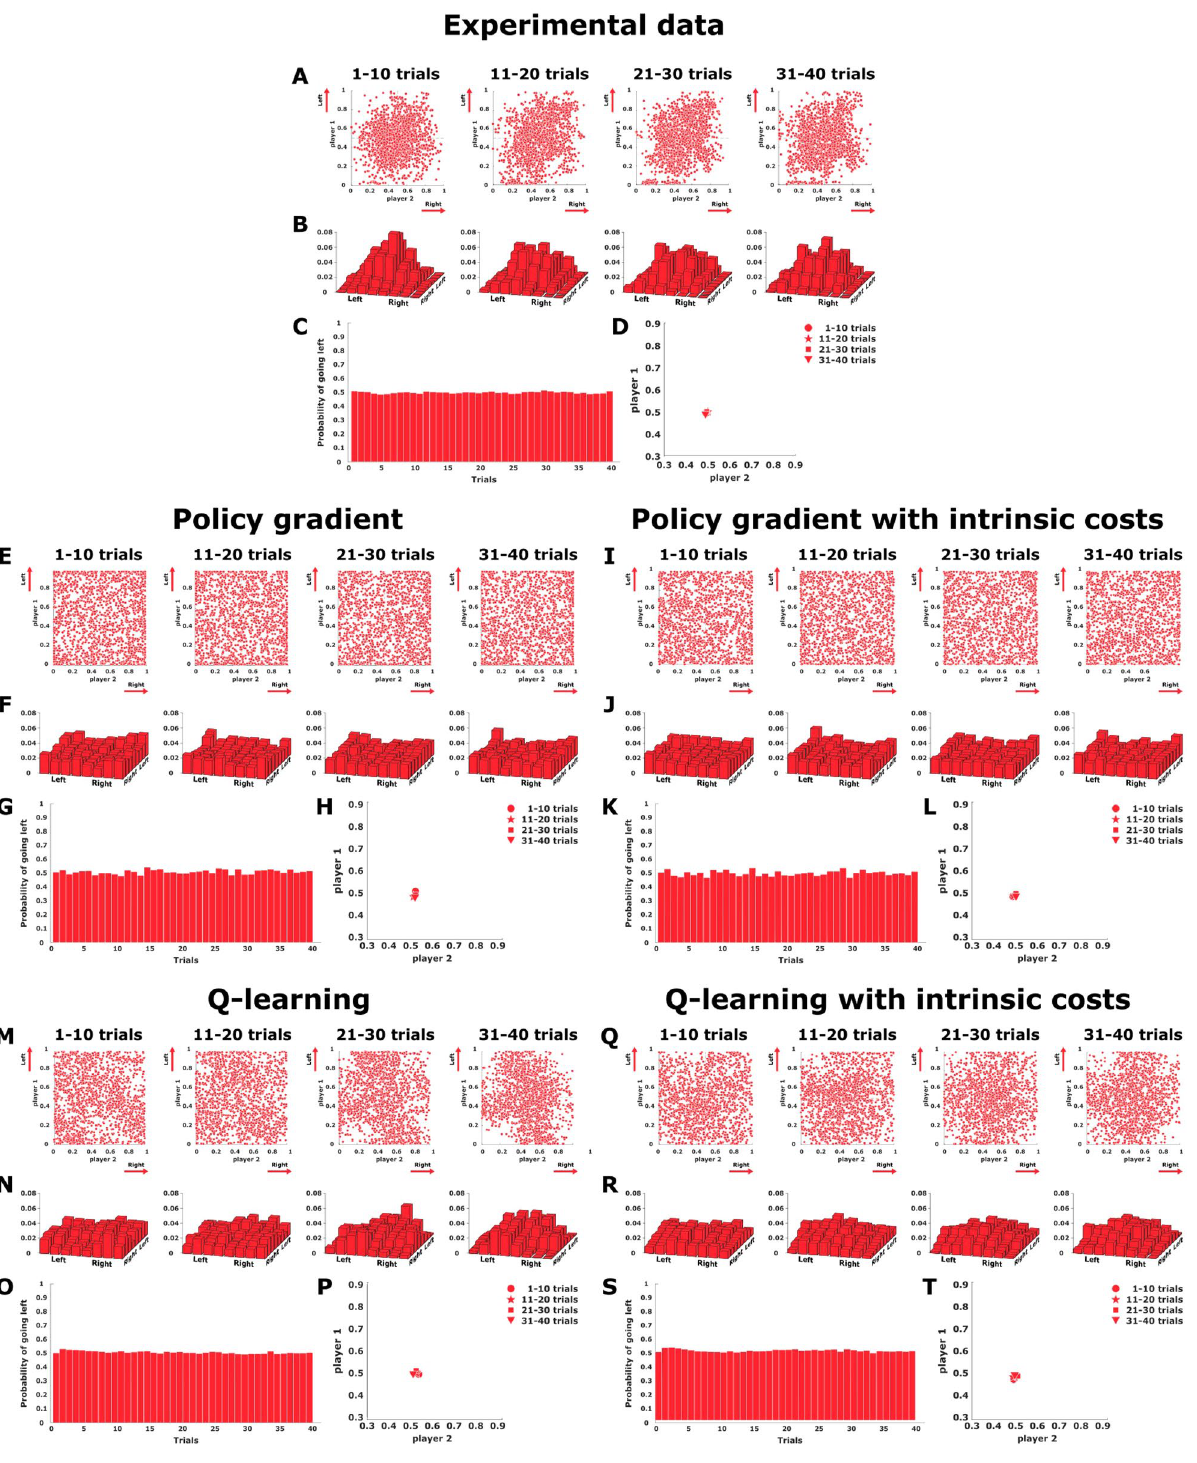
Figure 5. Symmetric matching pennies. ( A ),( E ),( I ),( M ), and ( Q ) show final decisions as a scatter plot in the x 1 x 2 -plane, where subjects’ actions are expected to cluster around the center of the workspace. ( B ),( F ),( J ),( N ), and ( R ) show a histogram binning of the experimental scatter plots. ( C ),( G ),( K ),( O ), and ( S ) present the change of the mean endpoint (averaged for both players) for each trial across the block of 40 trials. ( D ),( H ),( L ),( P ), and ( T ) show the direction of adaptation in the endpoint space. The experimental data is shown in the top, the four continuous models are below. Created using MATLAB R2021a (https:// www. mathw orks. com) 43